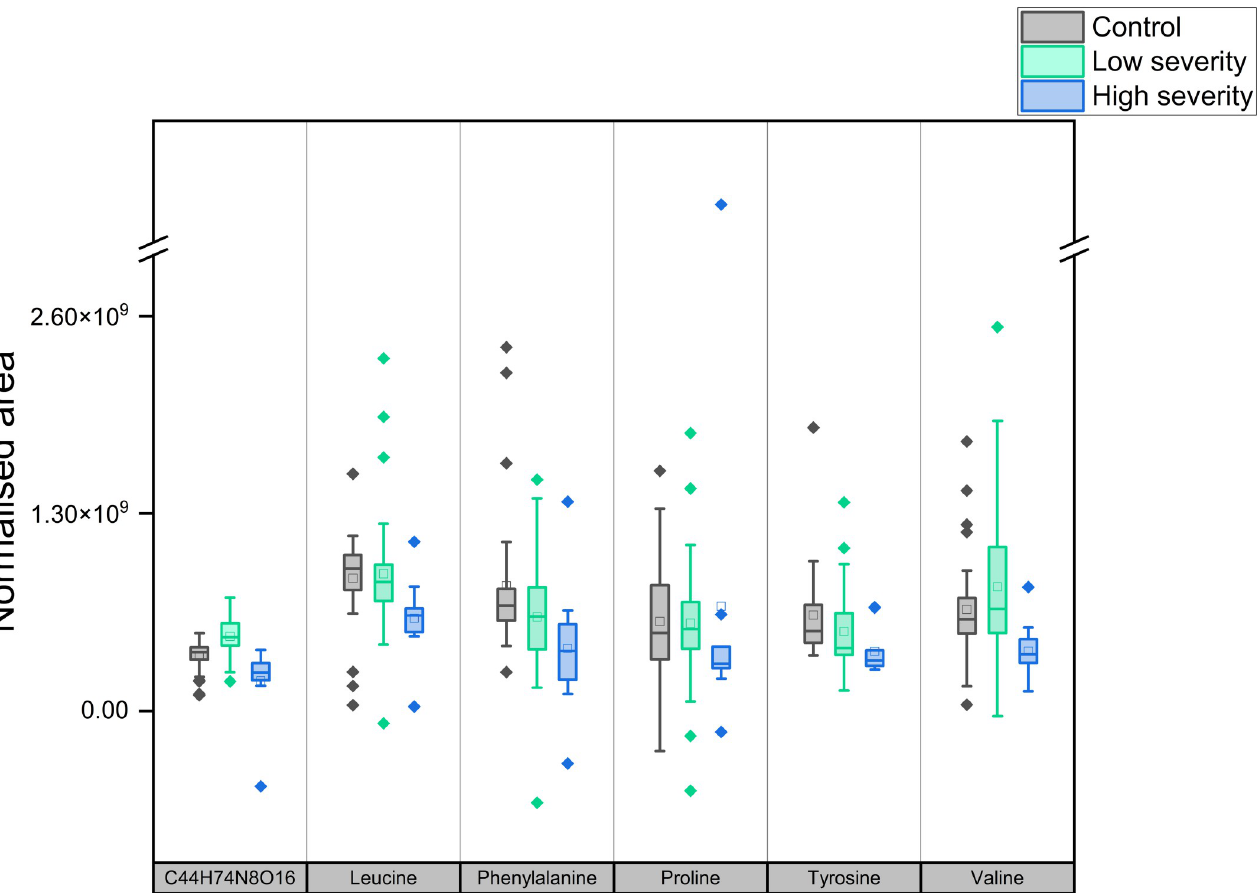
Fig 4. Boxplots of features selected for ability to differentiate high and low COVID-19 severity (corresponding p-values for high and low severity, left to right: < 0.001, 0.041, 0.051, 0.65, 0.16, and 0.02).